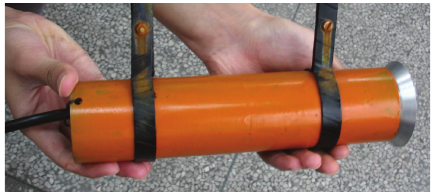
Figure 8: The Hybrid transducer prototype (including